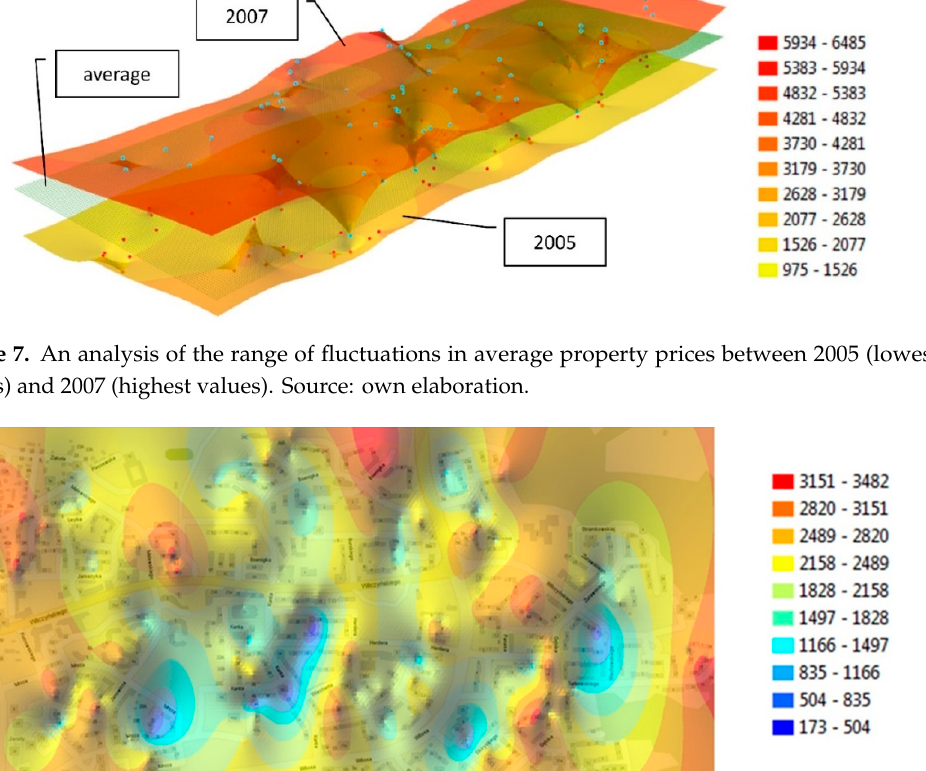
Figure 8. The location of differential price zones between 2005 and 2007 in the analyzed area, generated for base fields in a GRID structure with 0.0001° resolution. Source: own elaboration. Differential diagrams generated for every epoch relative to the average for the entire period of